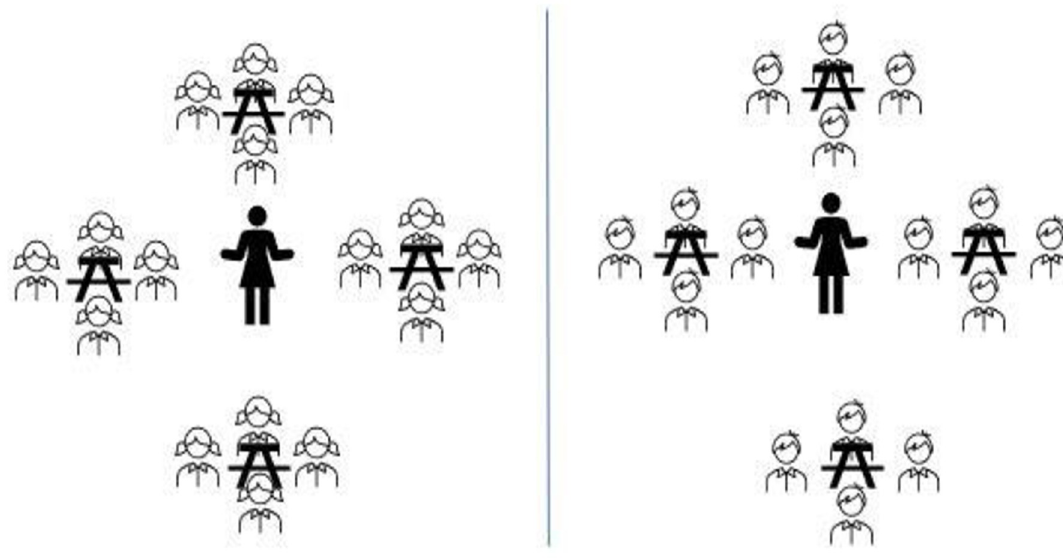
Fig 3. Single-gender collaborative learning (groups of (4W) or (4M)).